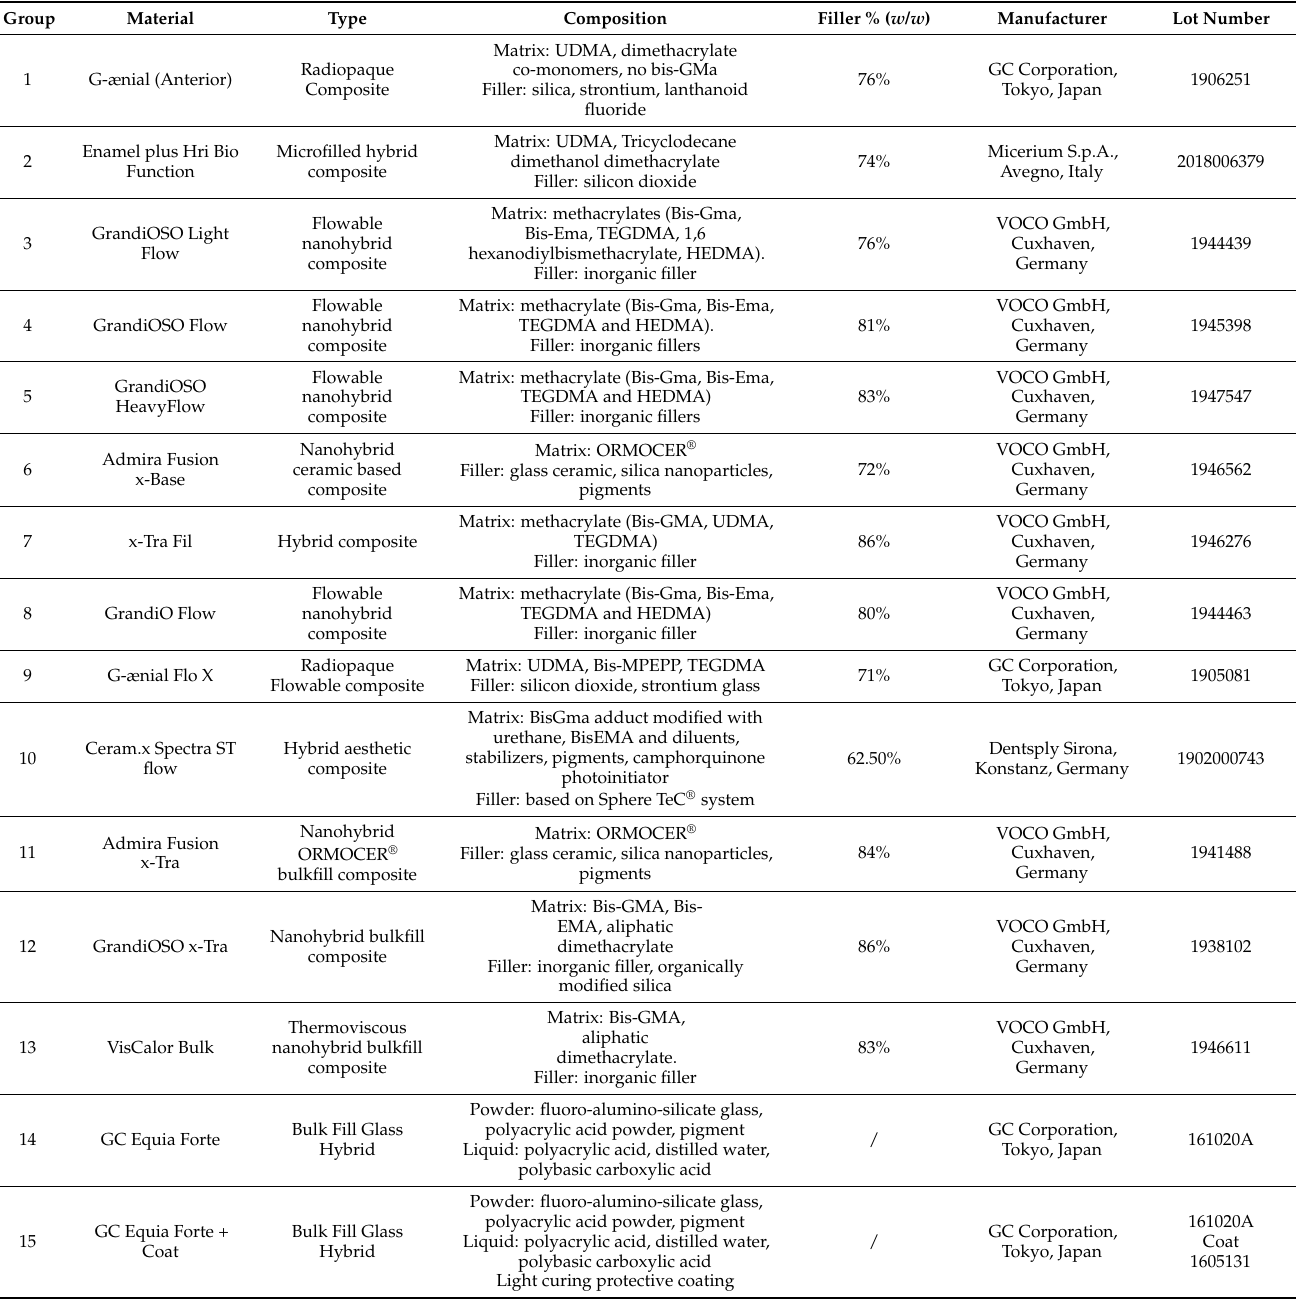
Table 1. Restorative dental materials tested in the